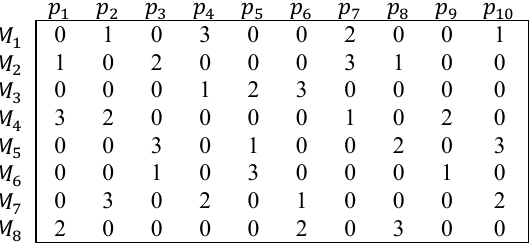
Exceptional Displacement Time parts of parts